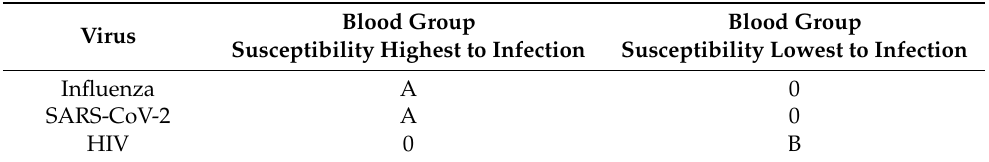
Table 2. Susceptibility to viral infection based on blood groups. Blood Virus